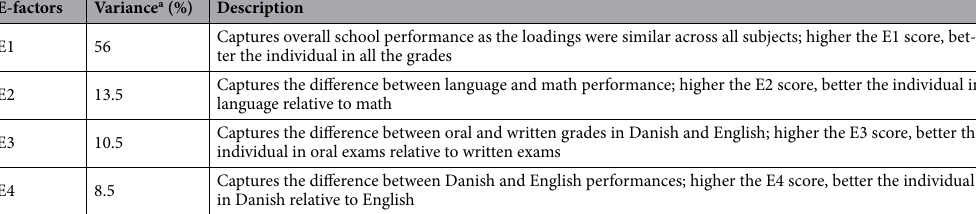
Table 2. Description of E-factors. a The variance estimate is the proportion of the variance explained individually by the E-factors in the school grades. The factors E2, E3 and E4 all capture only the relative performance hence should be interpreted carefully. For example, E2 informs only if an individual is better in language relative to math. E2 score can be high even when the individual is poor overall in both language and math (in comparison to others), but worse in math compared to language.